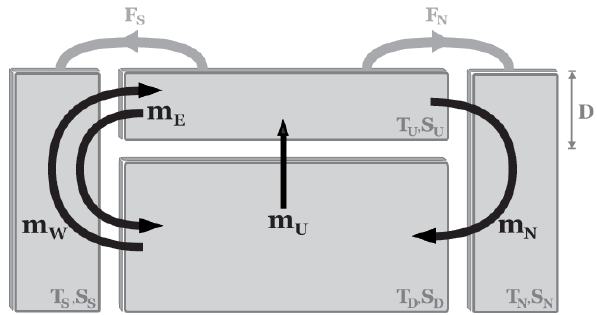
Figure 1. Schematic of the conceptual model as suggested in Fürst and Levermann (2012) and used here. The depth of the pycno- cline D is determined by the balance between the northern deep water formation m N , the upwelling in the low-latitudes m U in re- sponse to downward mixing, the Ekman upwelling m W and the eddy-induced return flow m E . Salinity is advected along with these transport processes and determines together with a fixed tempera- ture distribution the horizontal density differences. The differences are between low-latitudinal box and northern box, 1ρ , and low- latitudinal and southern box, 1ρ SO , respectively. The density dif- ferences, in turn, determine the northern sinking, m N ∝ D 2 1ρ , and the eddy-induced return flow, m E ∝ D1ρ SO